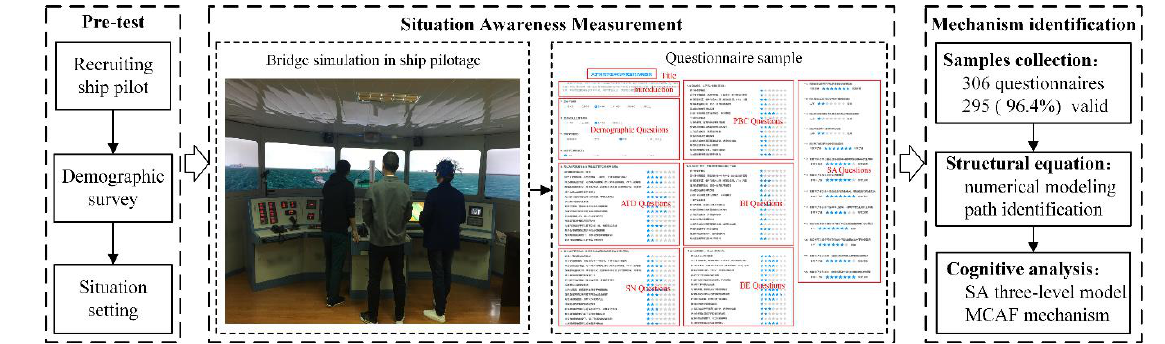
Figure 2. Research framework.